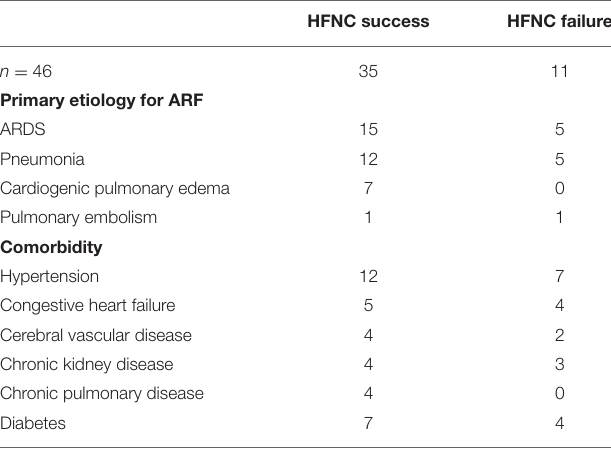
TABLE 2 | Summary of primary etiology for ARF and the comorbidities.